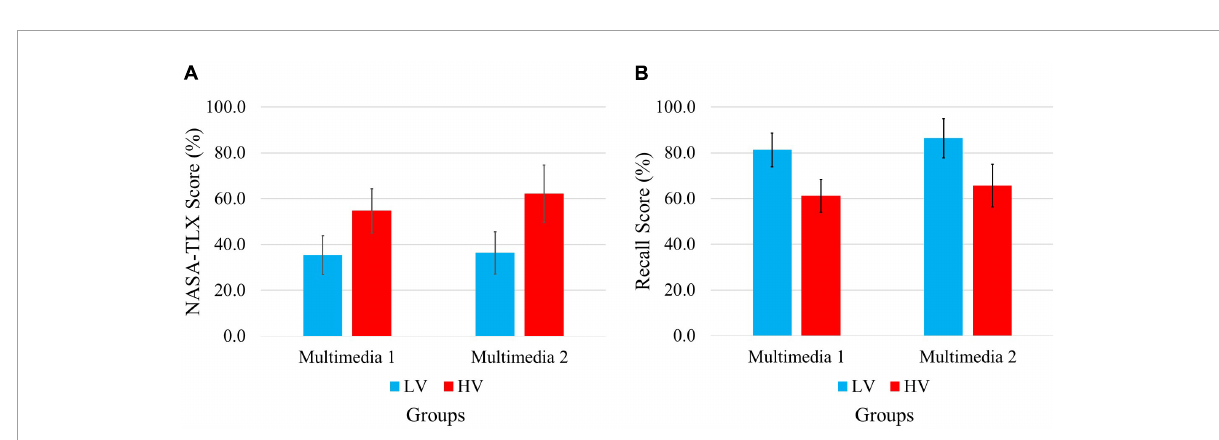
FIGURE5 Comparison of (A) NASA-TLX scores and (B) recall test scores in two experimental conditions. In each graph the scores [NASA-TLX scores in panel (A) and Recall scores in panel (B) ] are compared between two conditions (LV and HV) for each multimedia (Multimedia 1 and Multimedia 2). The scores have been scaled in the range [0, 100].